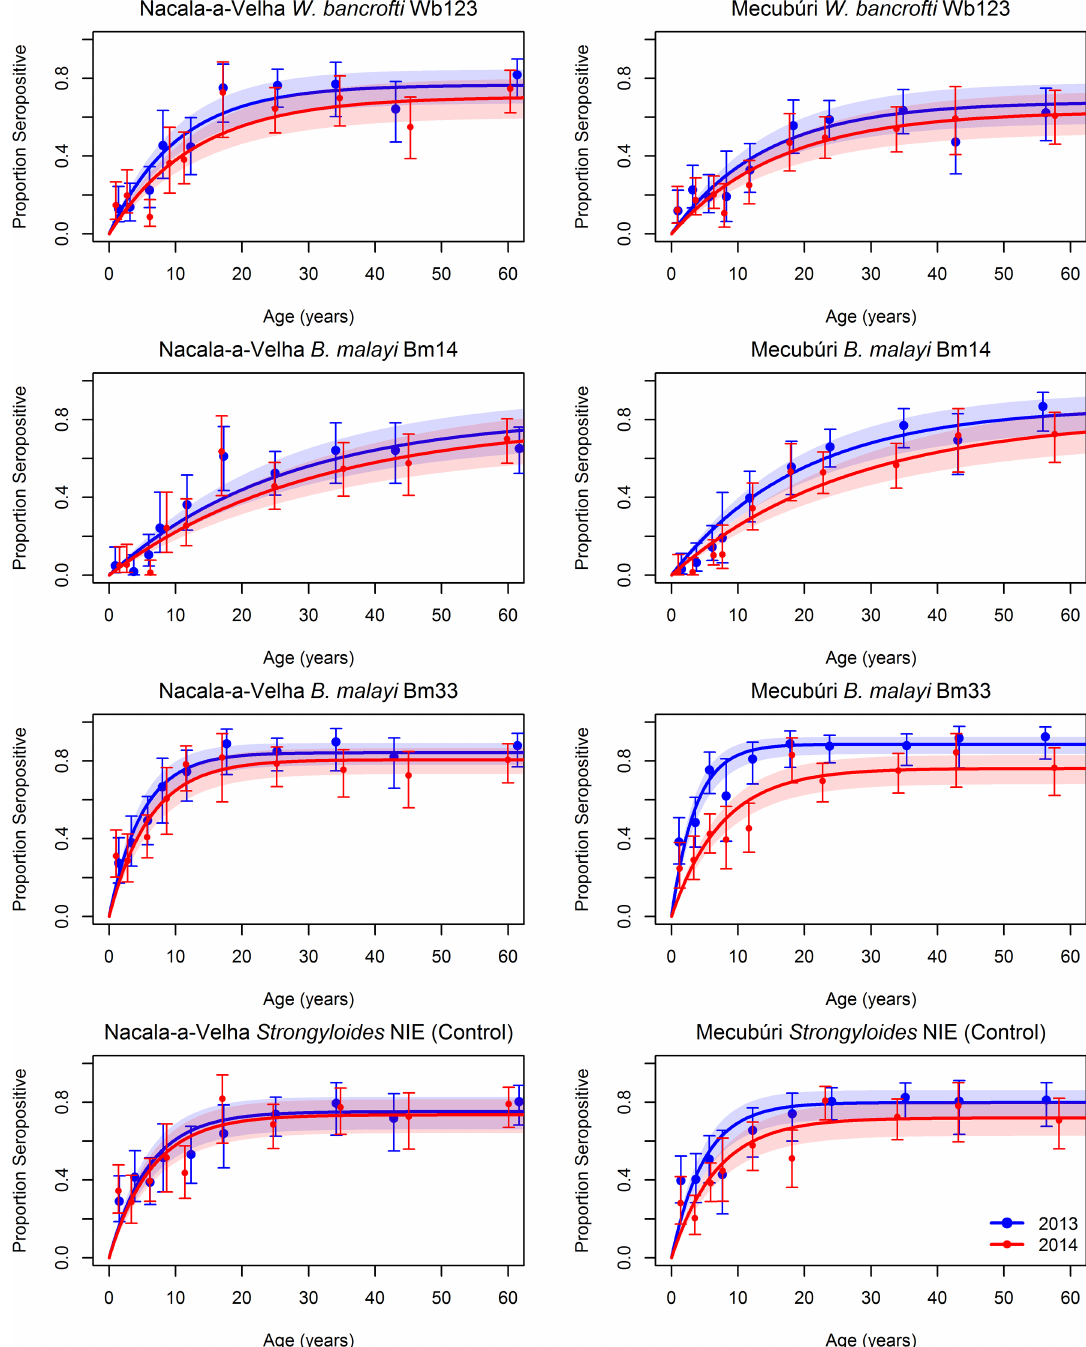
Fig 3. Seropositivity by age for antibodies to three lymphatic filariasis antigens and the Strongyloides NIE (control) antigen in community members sampled during household surveys in Nacala-a-Velha and Mecubu´ri Districts, Northern Mozambique, 2013–2014. Points represent estimates and 95% confidence intervals for seropositivity for each age category, curves represent the fit of a catalytic conversion model, and shaded areas represent the 95% confidence intervals of model fit: blue for 2013, red for 2014, and purple for the